Question: Compose a caption that would accompany this figure in a paper.
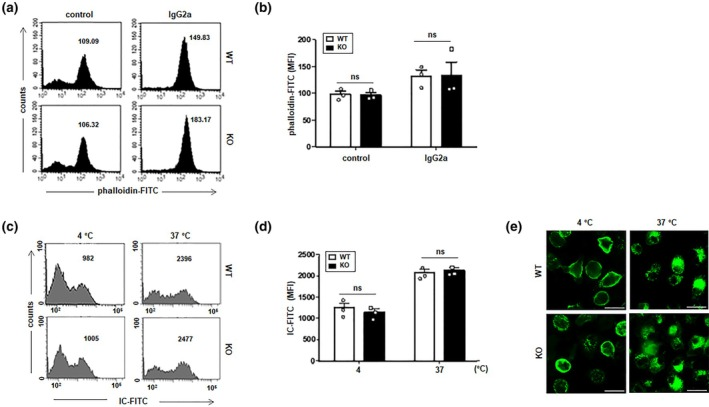
Answer: Actin polymerization and IC uptake were preserved in ARAP‐KO BMDCs. (a, b) Flow cytometric analysis of F‐actin levels following FcγR stimulation. (a) WT and ARAP‐KO BMDCs were cultured with plate‐bound IgG2a for 24 h, stained with FITC‐conjugated phalloidin, and analyzed for cellular polymerized F‐actin by flow cytometry. The numbers indicate the MFIs of the cells in the unstimulated control and IgG2a‐stimulated samples. Histograms are representative of three separate experiments. (b) The MFIs are presented as the mean ± s.e.m. of three separate experiments. Significant comparisons were determined by two‐way ANOVA (ns, no significance). (c–e) Quantification of IC uptake at 37°C. WT and ARAP‐KO BMDCs were incubated with fluorescent ICs at 4°C or 37°C for 30 min and fixed with 4% PFA. (c) IC uptake was analyzed by flow cytometry. The numbers indicate the MFIs of cells incubated at 4°C or 37°C. The histograms are representative of three separate experiments. (d) The MFIs are presented as the mean ± s.e.m. of three separate experiments. Significant comparisons were determined using two‐way ANOVA (ns, no significance). (e) The cells incubated with fluorescent ICs at 4°C or 37°C were analyzed using fluorescence microscopy. Representative images are shown. Scale bars = 10 μm.